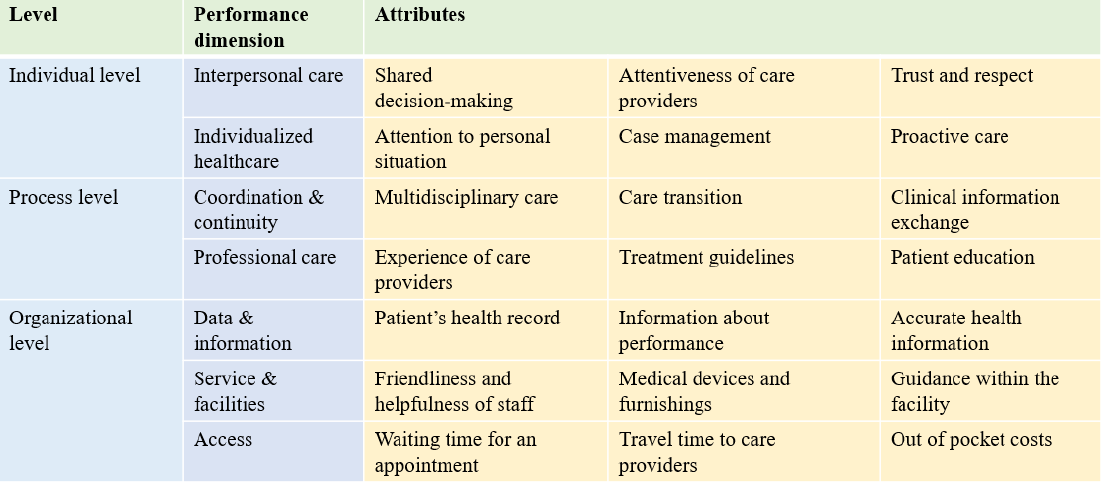
Table 1. Attributes and levels used in the discrete choice experiment.